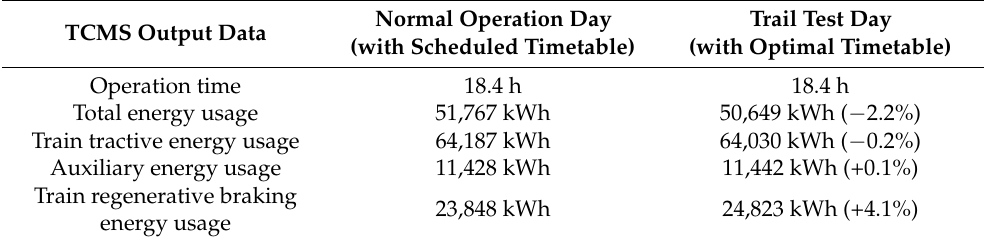
Table 5. Comparison between the optimal timetable trial test and normal